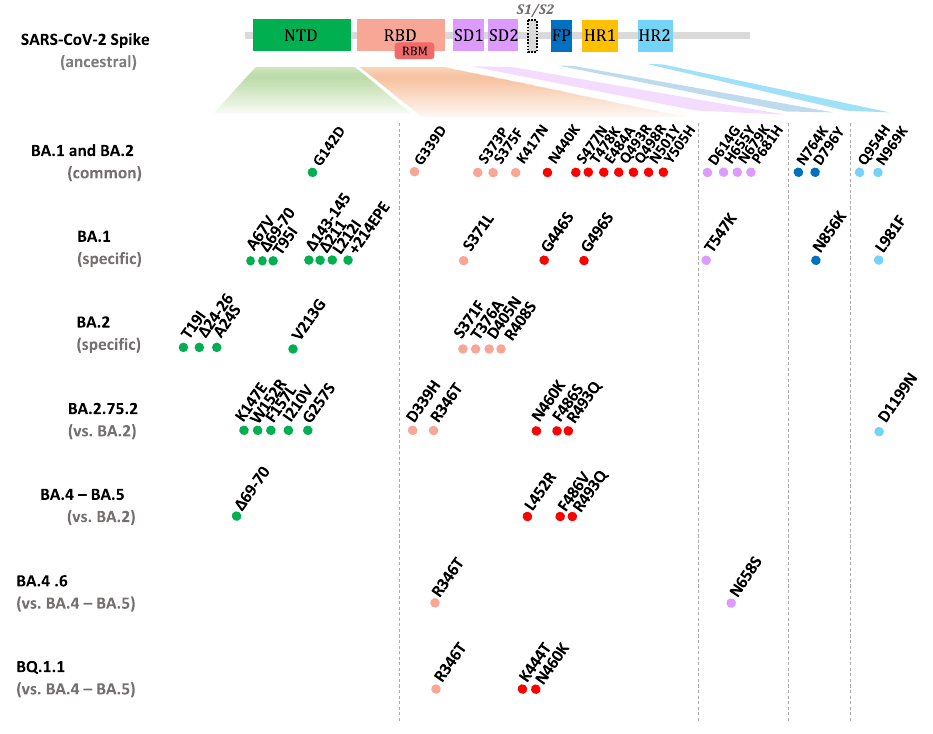
Fig. 2 | Mutations present in the spike proteins of Omicron subvariants. NTD, N-terminal domain; RBD, receptor binding domain; RBM, receptor binding motif; SD1,subdomain1;SD2,subdomain2;FP,fusionpeptide;HR1,heptadrepeat1;HR2,